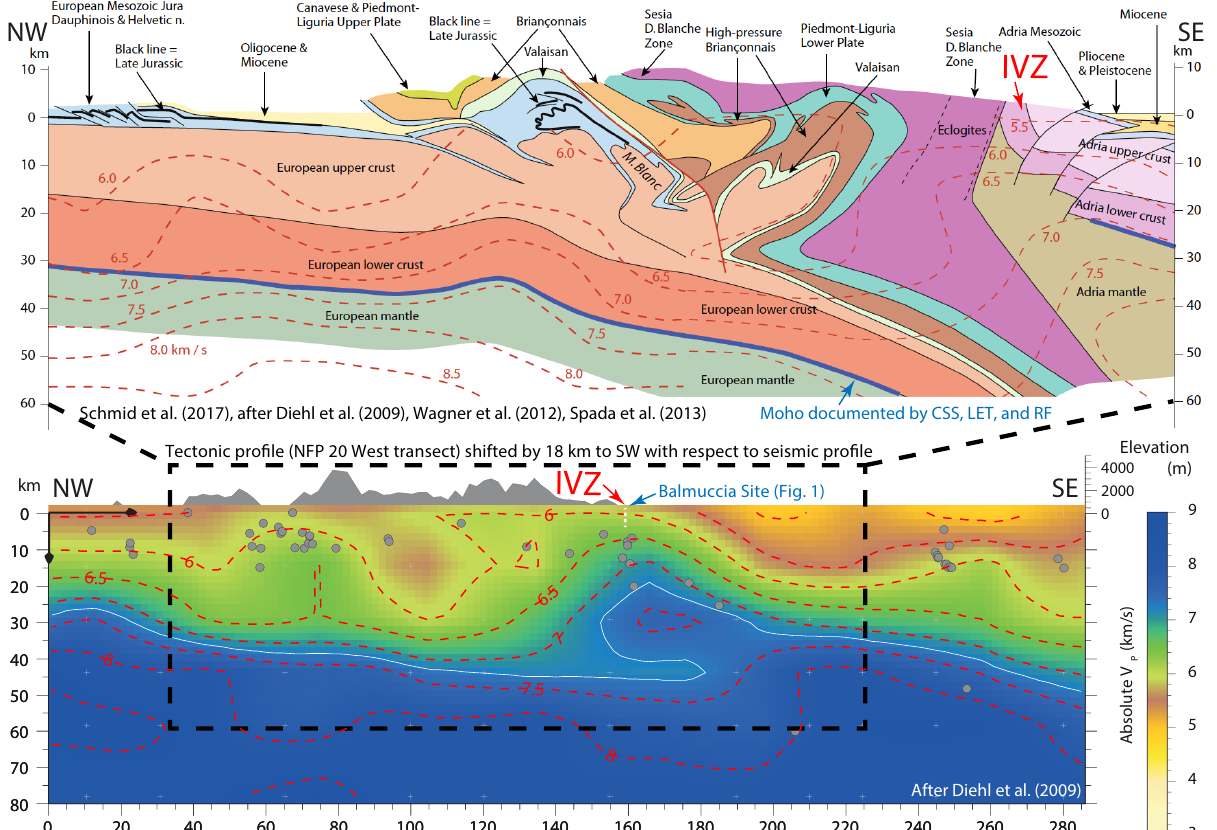
Figure 2. Northwest–southeast geological–tectonic transect (NFP 20 western transect; Schmid et al., 2017) and seismic profile (Diehl et al., 2009) across the western Alps. The two profiles are superimposed with and partly based on vertical cross sections across the final P-wave velocity model of Diehl et al. (2009), indicated by red dashed lines. The Moho (blue line in the geological-tectonic profile) is taken from a combination of controlled-source seismology (CSS), local earthquake tomography (LET), and receiver function (RF) analysis (Wagner et al., 2012; Spada et al., 2013). Data sources and traces of the profiles are reported in Schmid et al. (2017). The vertical white dashed line in the seismic profile indicates the proposed core location (up to 4km depth) of Balmuccia site (Fig. 1). Note that the tectonic profile (NFP 20 western transect) is shifted by 18km to the southwest with respect to the seismic